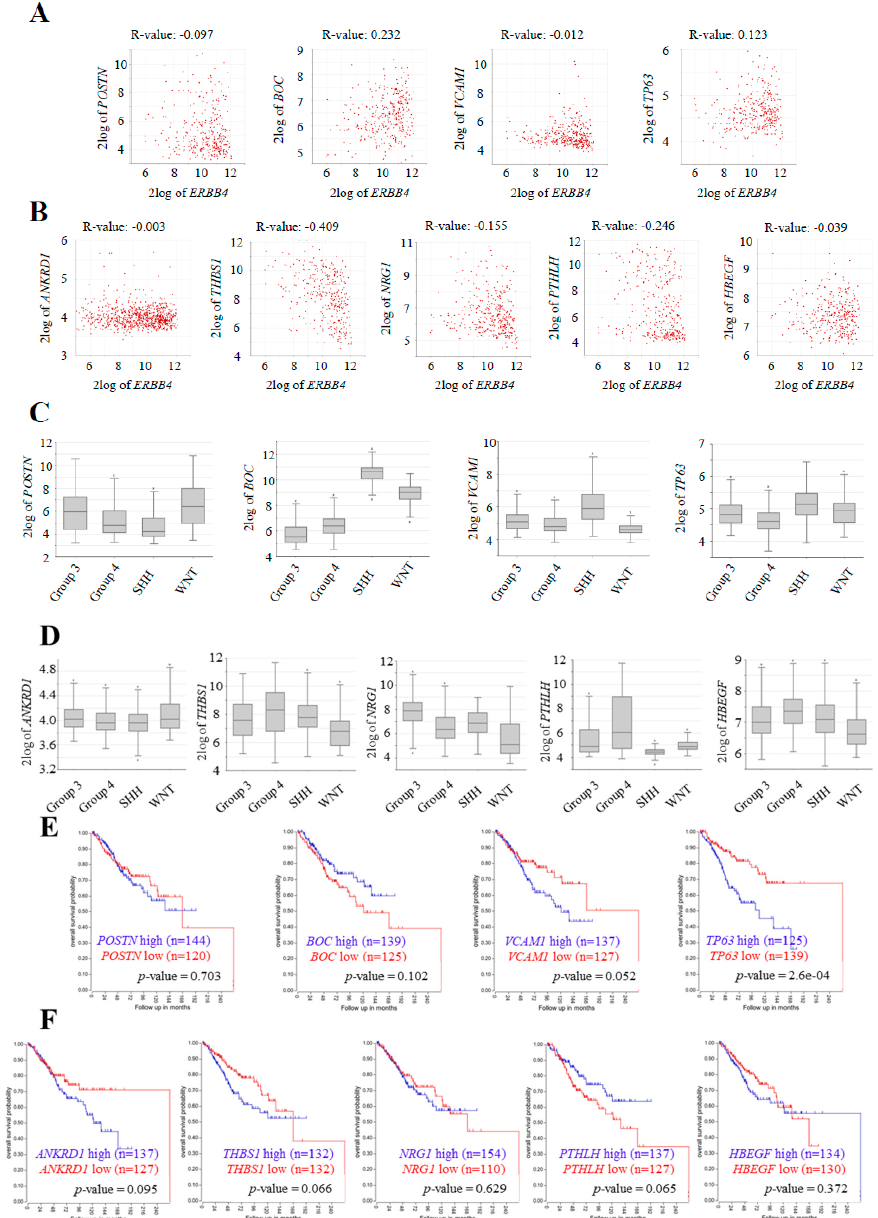
Figure 7. Expression and clinical impact of ERBB4 downstream genes in human samples of medulloblastoma. ( A , B ) Correlation analysis of ( A ) downregulated ( POSTN p -value = 0.079, BOC p -value = 2.38 × 10 − 5 , VCAM1 p -value = 0.835, and TP63 p -value = 0.027) and ( B ) upregulated ( ANKRD1 p -value = 0.955, THBS1 p -value = 1.48 × 10 − 14 , NRG1 p -value = 5.17 × 10 − 3 , PTHLH p -value = 6.91-06, and HBEGF p -value = 0.482) with ERBB4 expression for Cavalli cohort Group 4 patients’ ( n = 326) data. Boxplot of the log2 of ( C ) downregulated and ( D ) upregulated genes in the indicated medulloblastoma subgroups in Cavalli cohort ( n = 612). Kaplan–Meier curves for the Cavalli cohort Group 4 patients’ overall survival rates based on ( E ) downregulated and ( F ) upregulated expression ( p -values are indicated in each graph). All results were obtained from hgserver1.